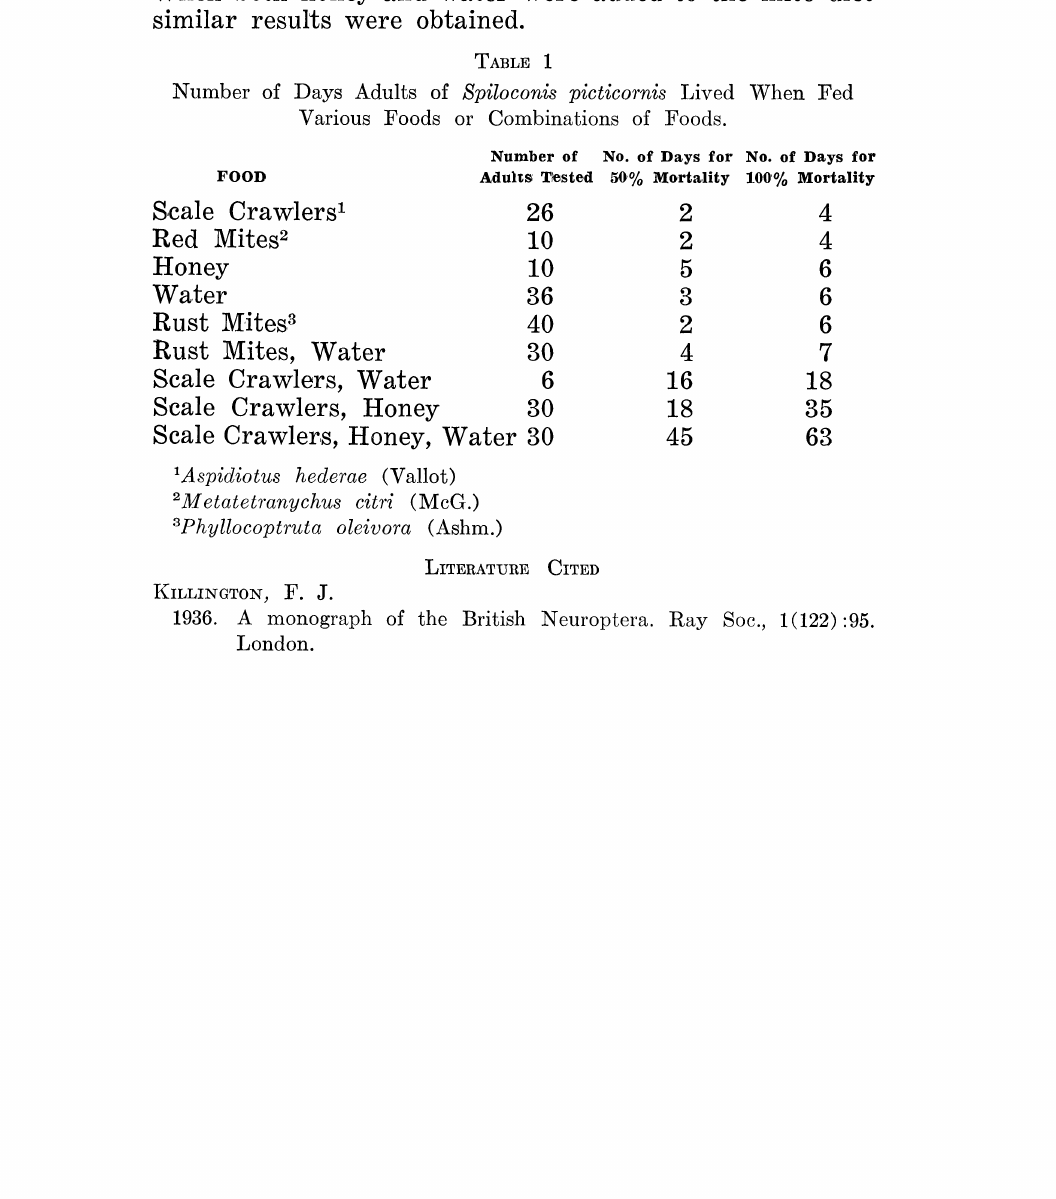
Number of Dys Adults of Spiloconis picticornis Lived When Fed Vrious Foods or Combinations of Foods. Number of No. of Days for No. of Days for